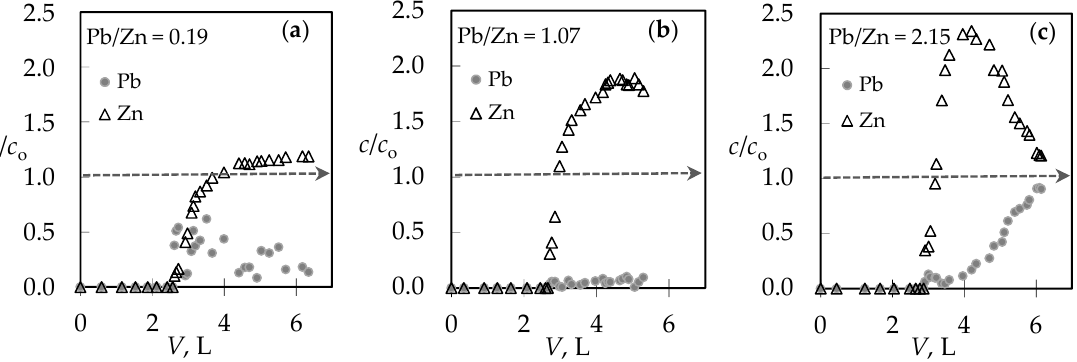
Figure 3. The breakthrough curves for each metal ion in the binary (Pb + Zn) solution for different Pb/Zn ratios: ( a ) Pb/Zn = 0.19; ( b ) Pb/Zn = 1.07 [43]; and ( c ) Pb/Zn = 2.15. Note: c / c o = c (Pb)/ c o (Pb) or c (Zn)/ c o (Zn).